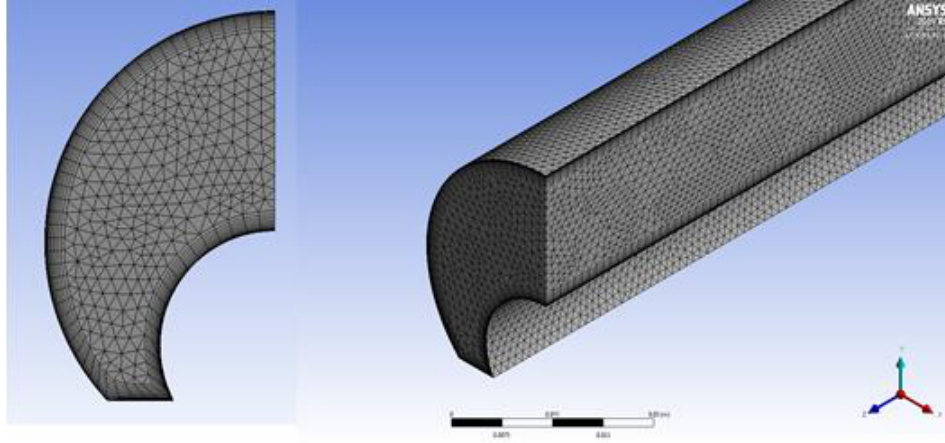
Figure 1. Unstructured grid system in a partially blocked annulus [25].